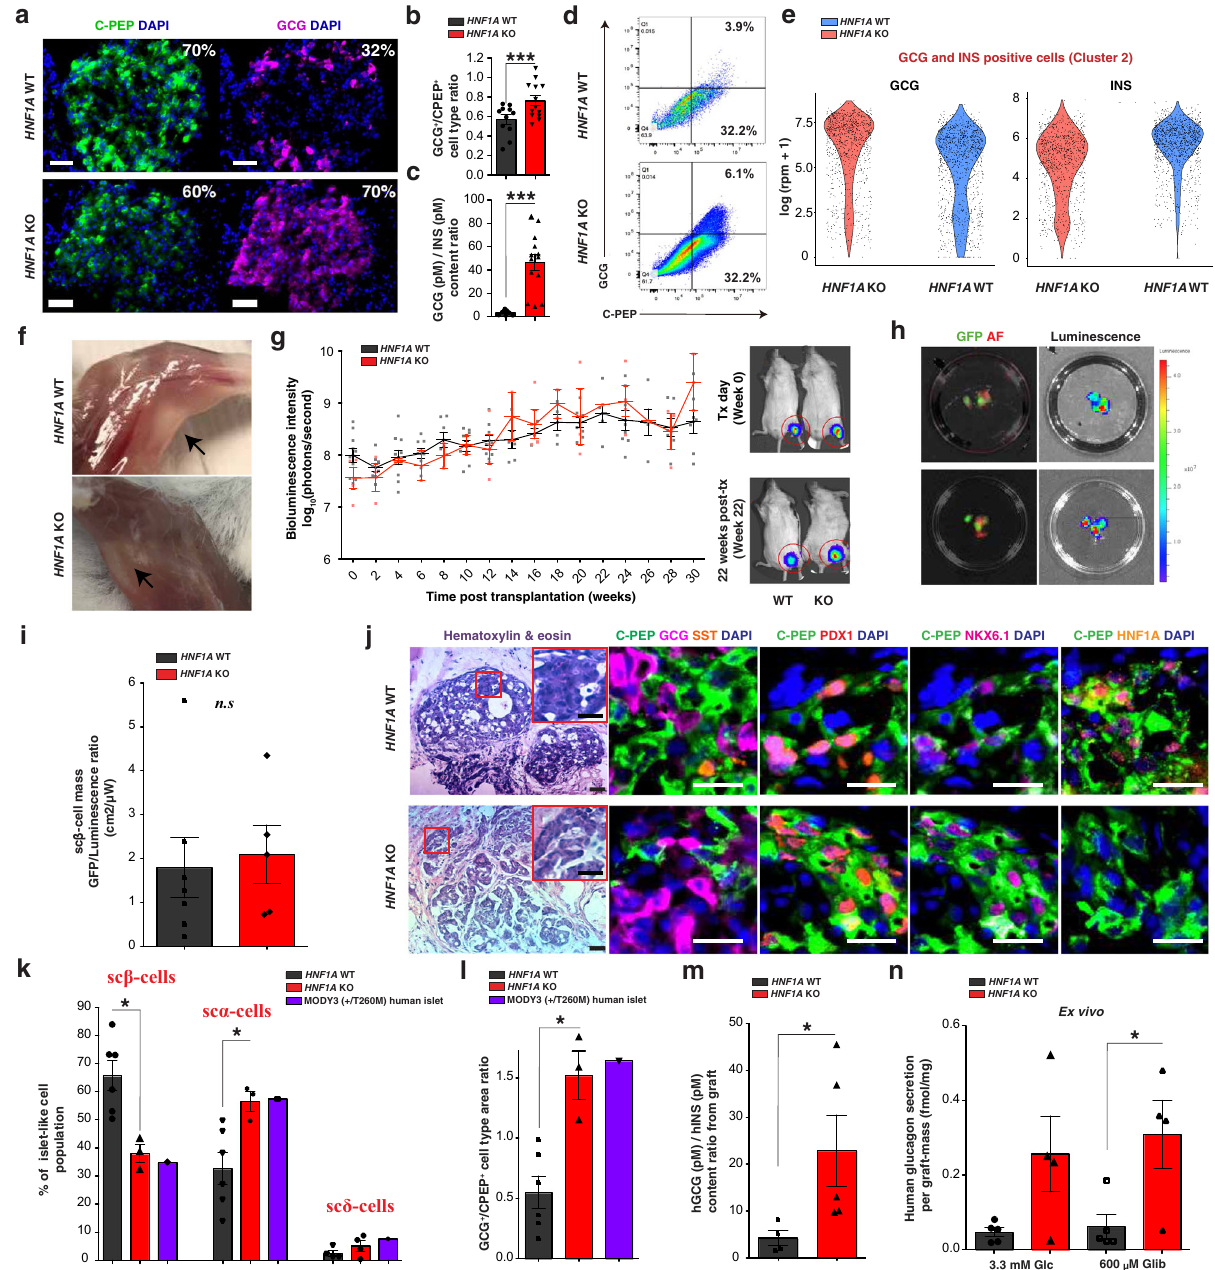
NKX6.1 + ), as well as glucagon- and somatostatin-positive cells were apparent in both hESC HNF1A WT and hESC HNF1A KO grafts (Fig. 2j). No double hormone-positive cells were identi fi ed in either genotype. Consistent with the in vitro studies, the percentage of sc α -cells in HNF1A KO compared to HNF1A WT islet-like structures was increased by 24% (Figs. 2k and S7k), leading to a signi fi cant increase in GCG + /CPEP + cell type ratio (Fig. 2l); comparable to cadaveric human islets of an HNF1A- MODY donor ( + /T260M) 29 (Fig. 2k, l). Ex vivo analysis of isolated HNF1A KO grafts showed an increase in glucagon protein content by ELISA (Figs. 2m and S7l, m). Glucagon secretion was higher in HNF1A KO grafts when stimulated with glibenclamide, a second-generation sulfonylurea drug compared to HNF1A WT grafts (Fig. 2n). Similarly, elevated glucagon secretion upon KCl stimulation was detected in vitro from